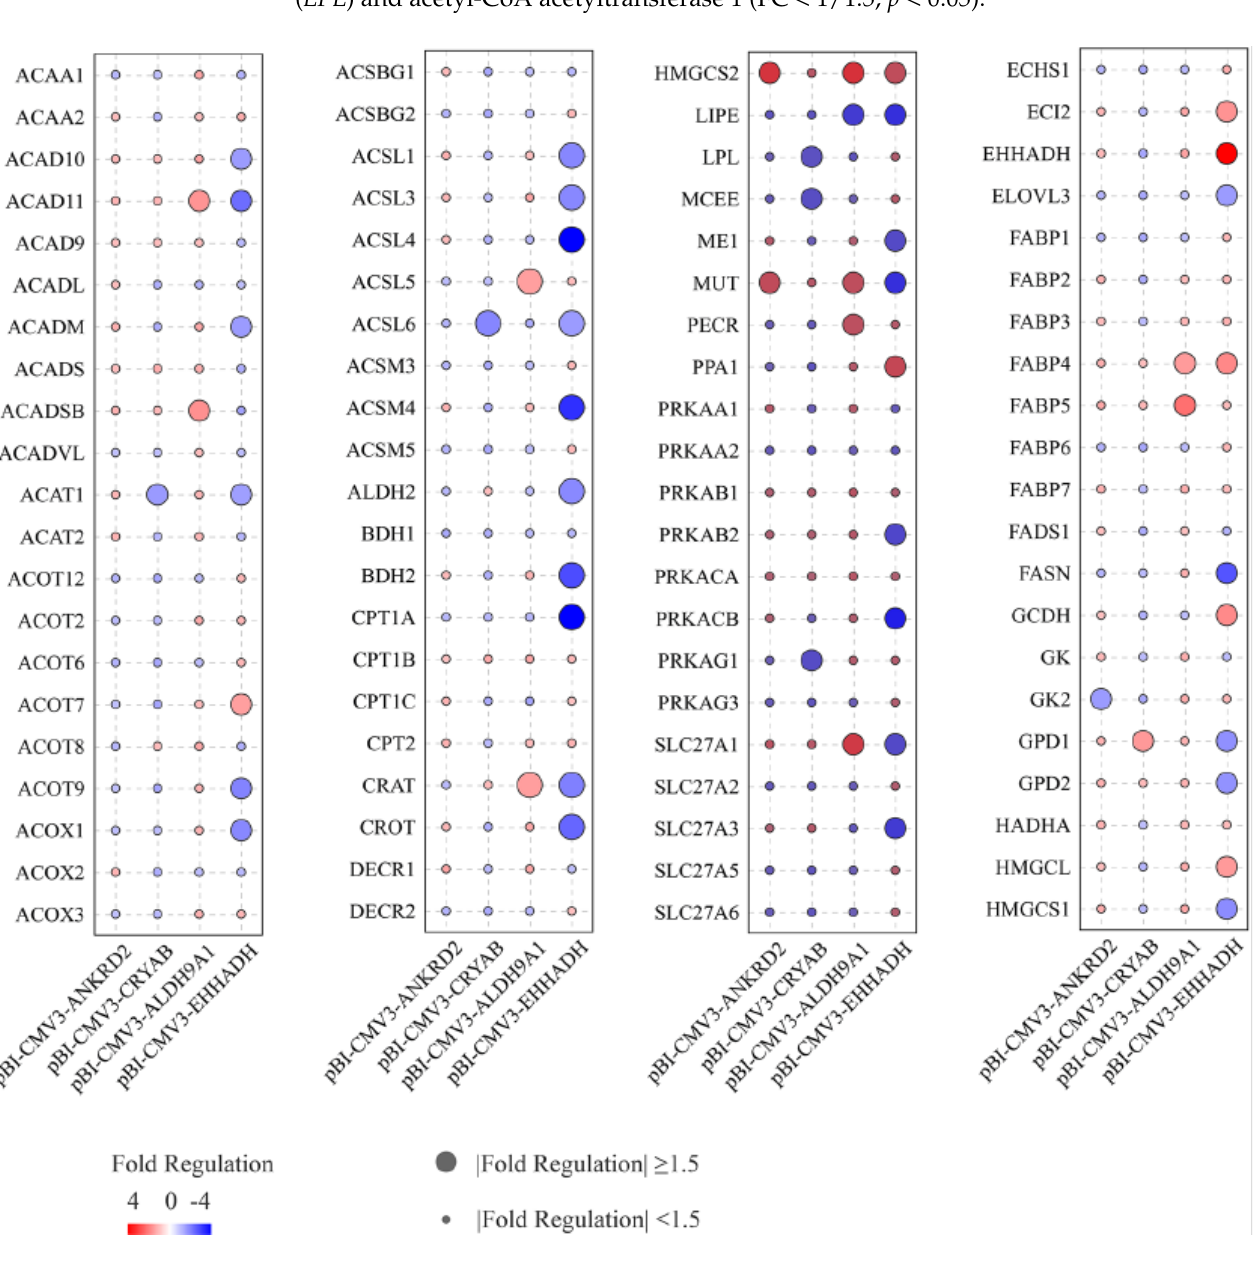
Figure 5. Regulation of genes related to fat and fatty acid metabolism by candidate genes.